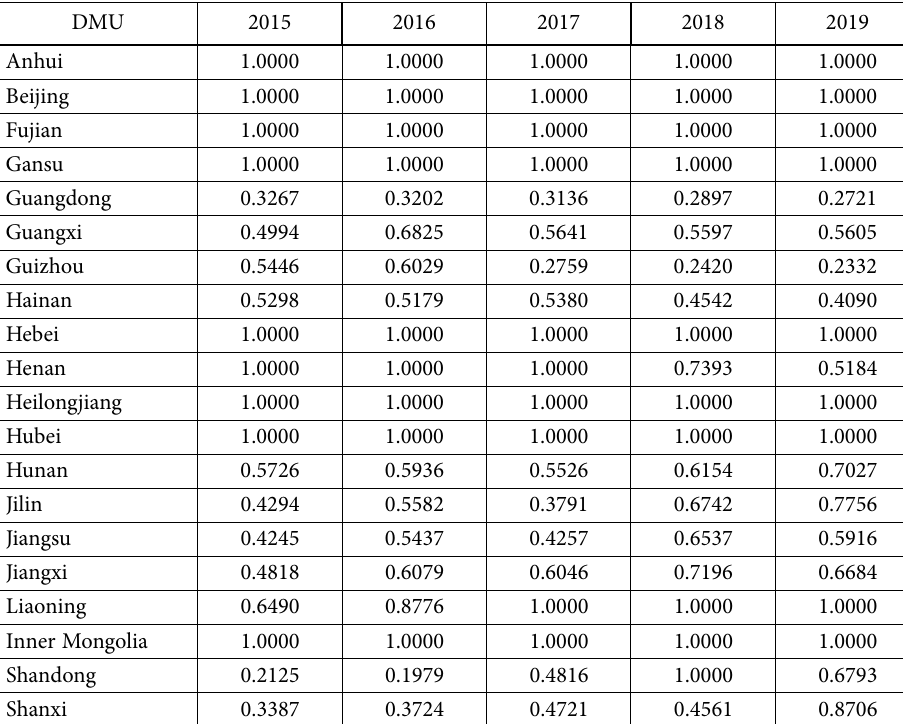
Table 7. Total output efficiency of each province from 2015 to 2019 DMU